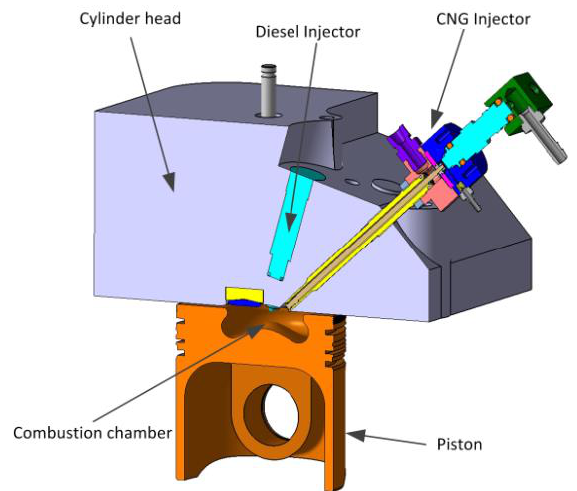
Fig. 22. The localization of the injector in CAD drawing of the cylinder head on the left and a custom gaseous-fuel injector with a parts of it on the right (reproduced from [14]) Fig. 23. Fuel injection process in two-stroke maritime engines, where the principle for the injection of low pressure gas through the cylinder liner during the upwards movement of the piston is clearly visible (reproduced from